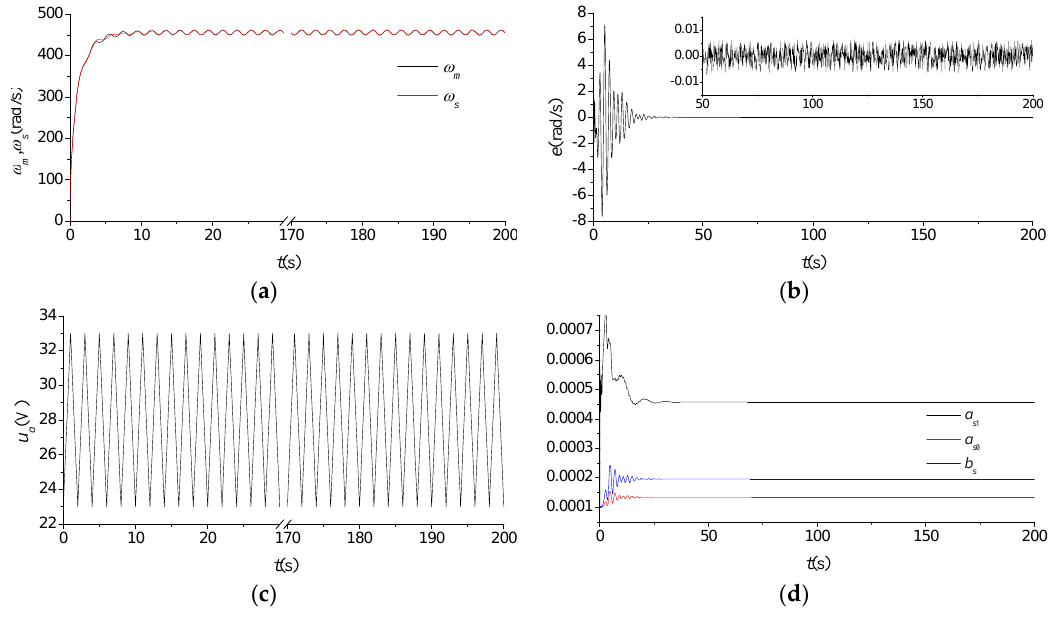
Figure 5. Experimental results for the input triangle wave. ( a ) ω m and ω s ; ( b ) e ; ( c ) u a ; and ( d ) the parameters of the soft sensor.